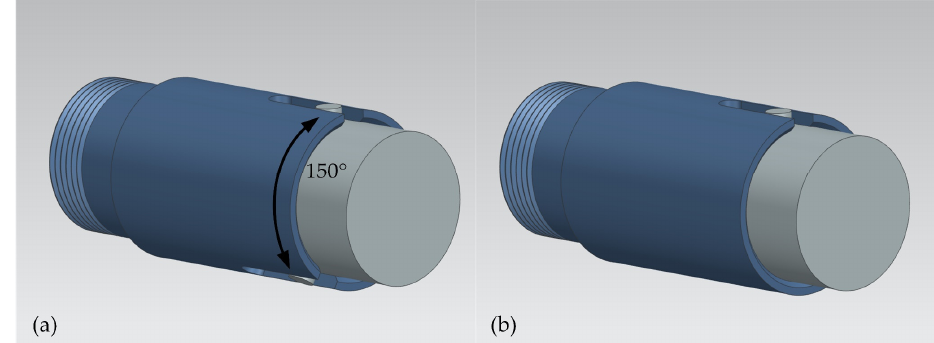
Figure 18. Aligning unit and locking unit in SEACON HydraLight Optical WMC: ( a ) dual keyway design, and ( b ) keyway design [96].